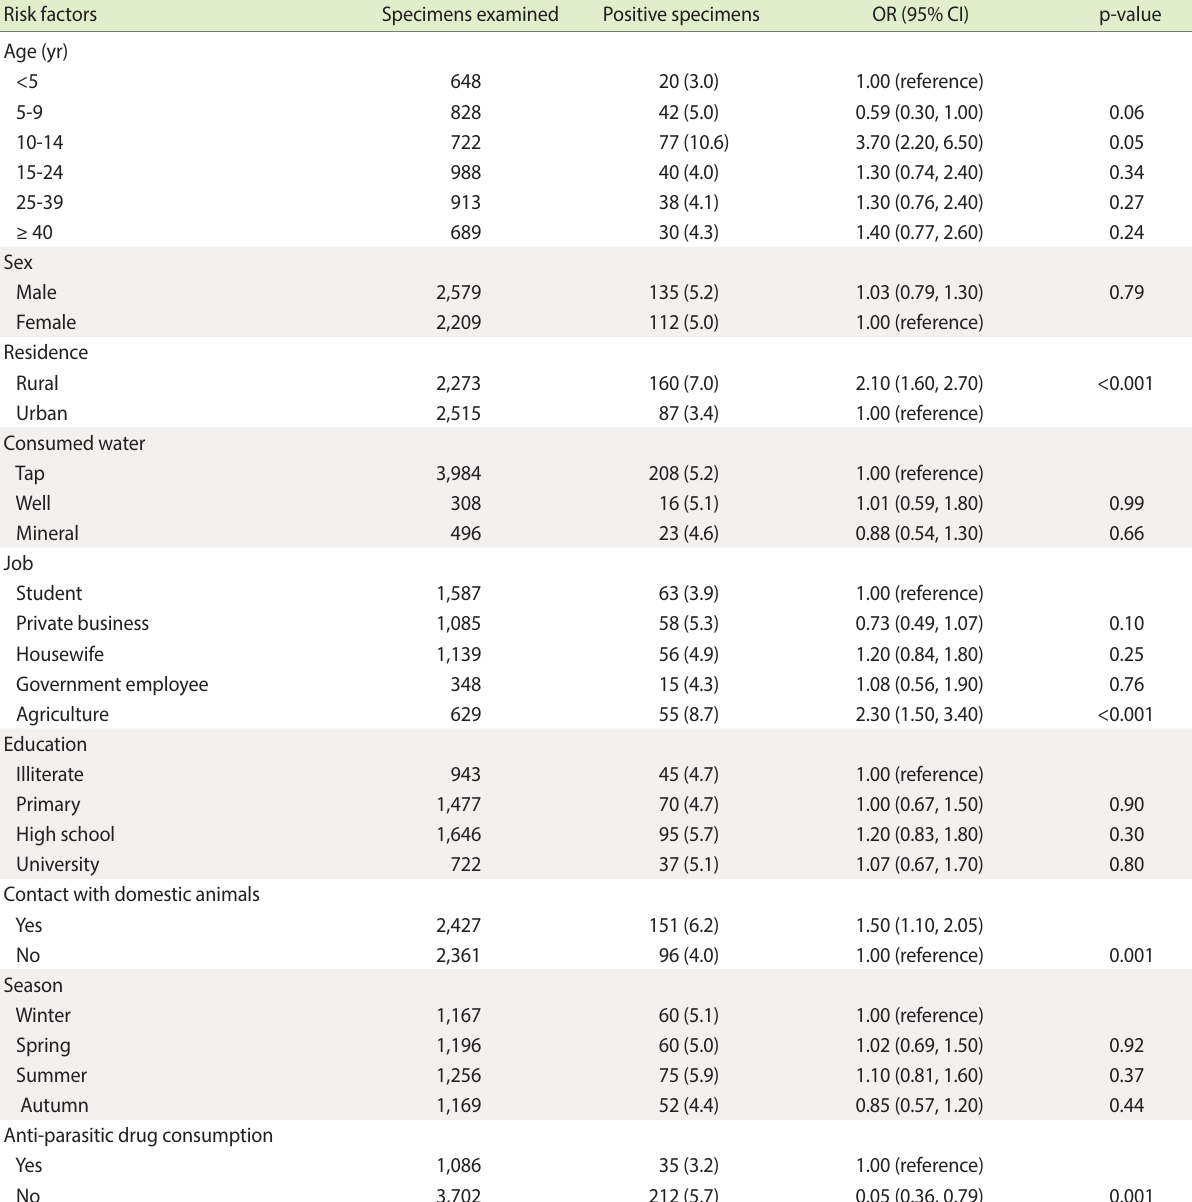
Table 1. Frequency of Blastocystis hominis in Mazandaran Province by demographic data and risk